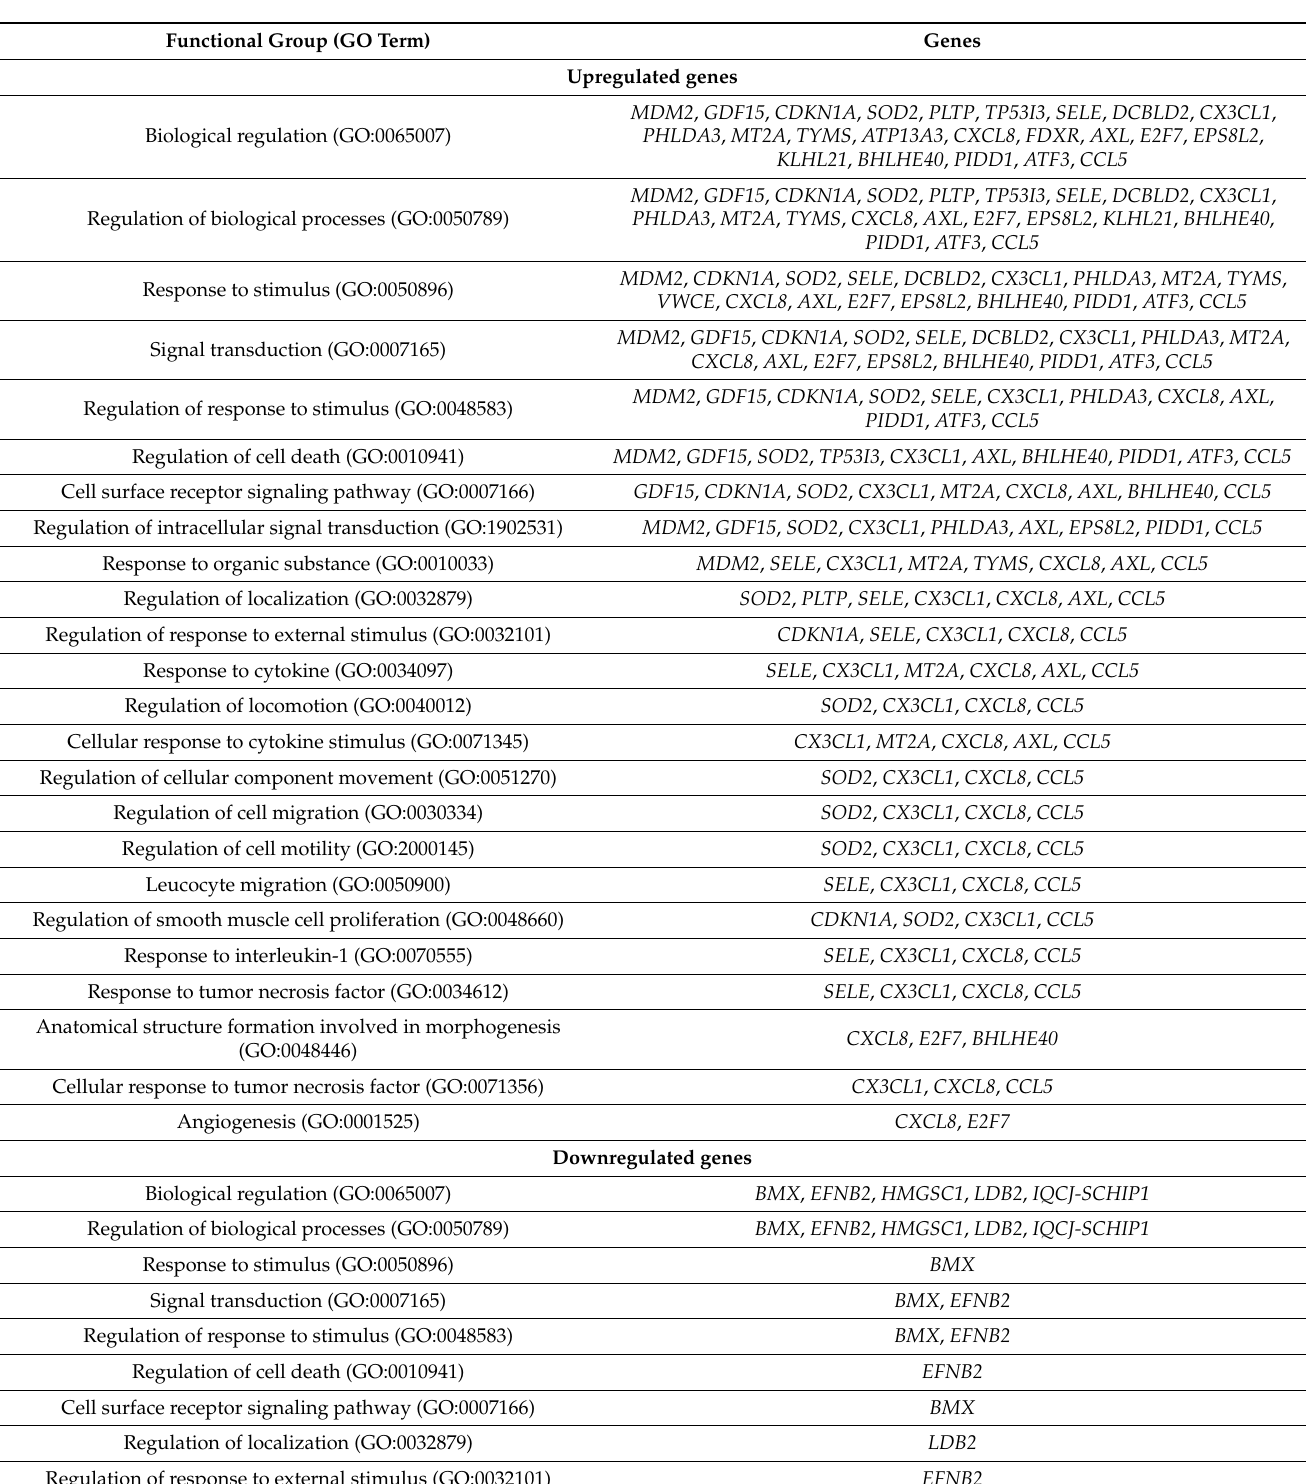
Table 2. Distribution of differentially expressed genes (DEGs) identified in Human Coronary Artery Endothelial Cells (HCAEC) exposed to mitomycin C (MMC) in comparison with the non- exposed control between functional groups of biological processes according to Gene Ontology enrichment